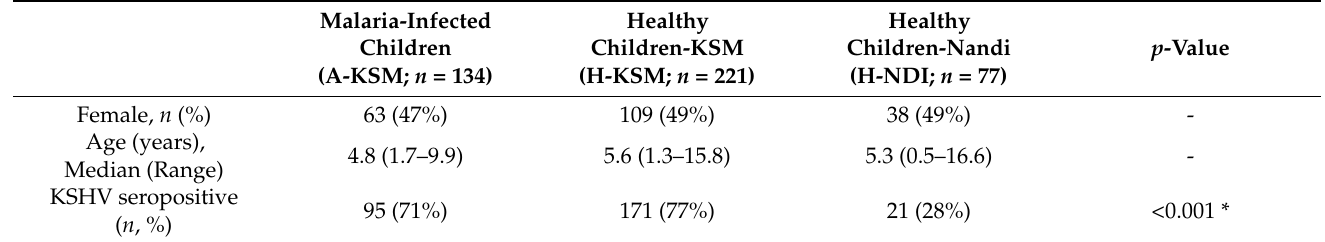
Table 1. Demographic characteristics of study participants.